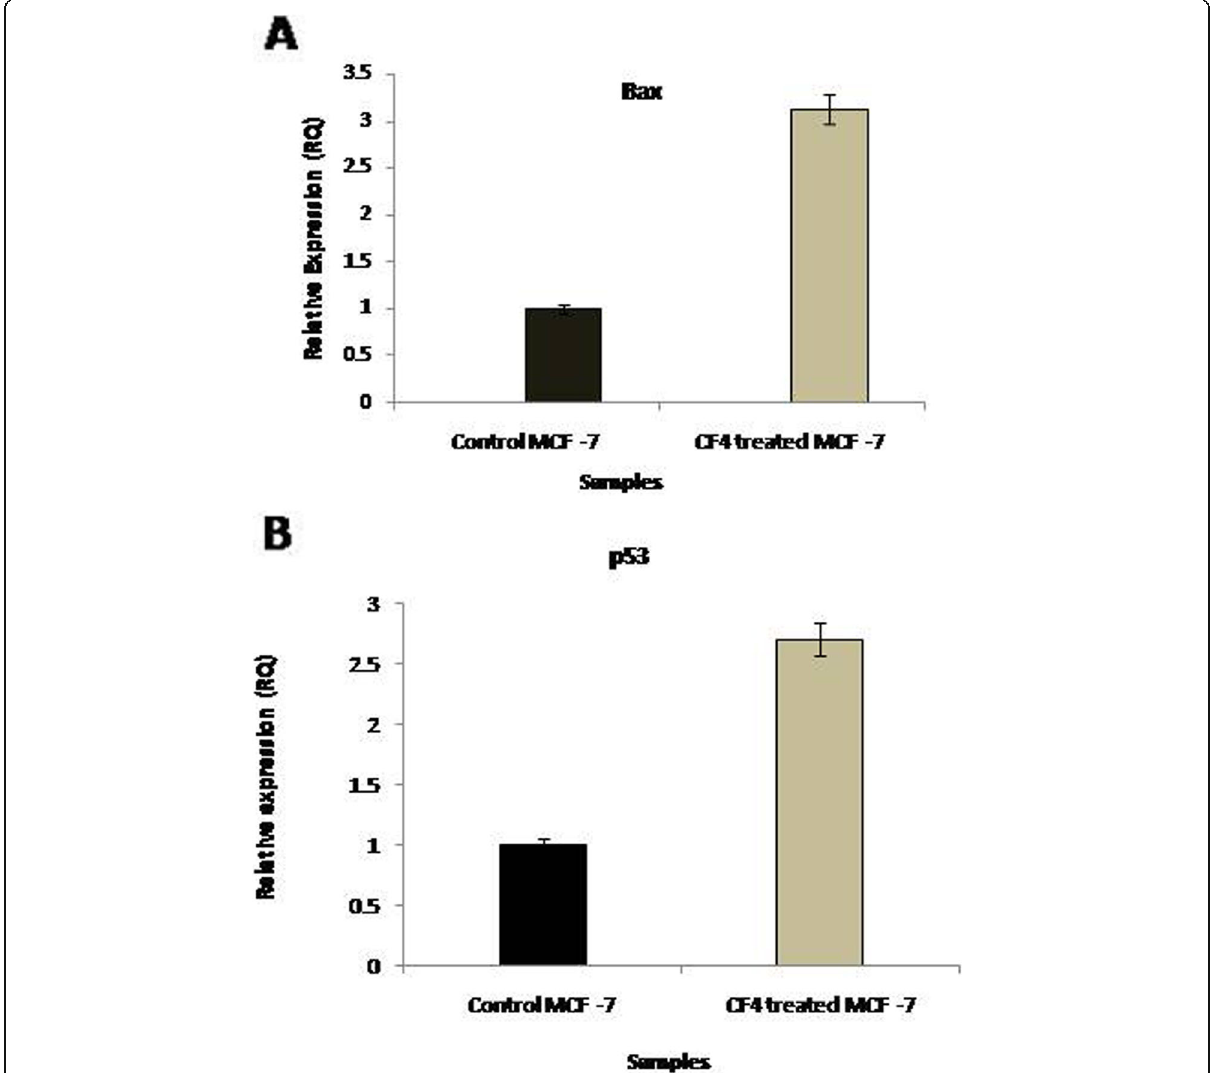
Fig. 9 Analysis of gene expression by qRTPCR. a Relative expression of Bax gene in treated and untreated cells. b Relative expression of p53 gene in treated and untreated